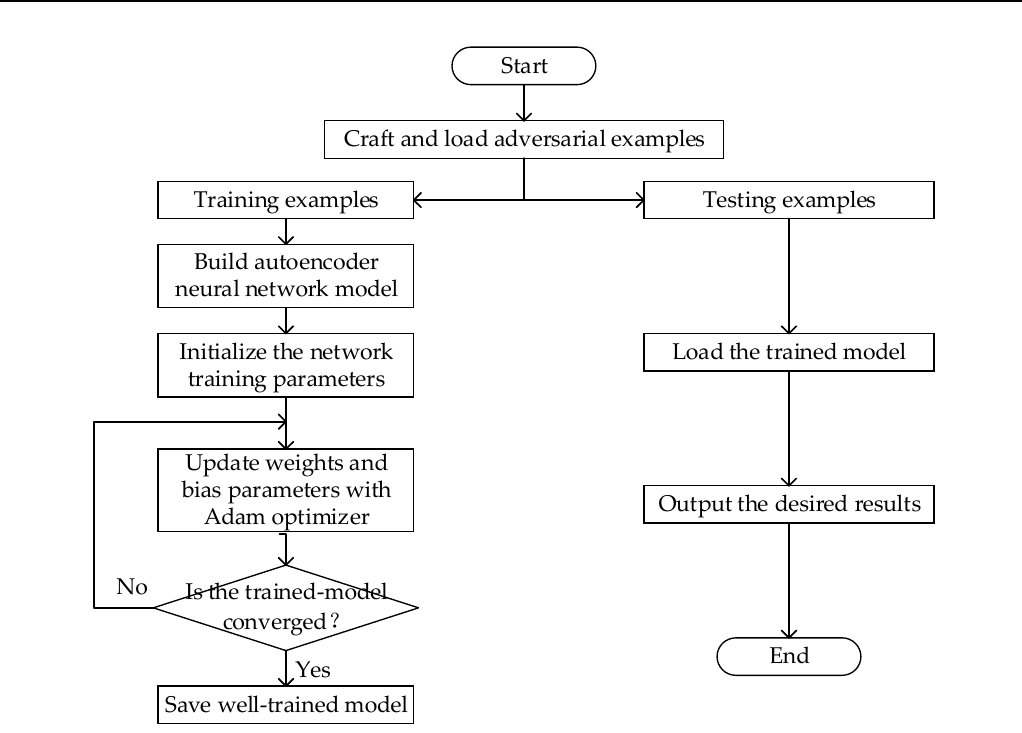
Figure 3. Flow chart of the training and testing process.